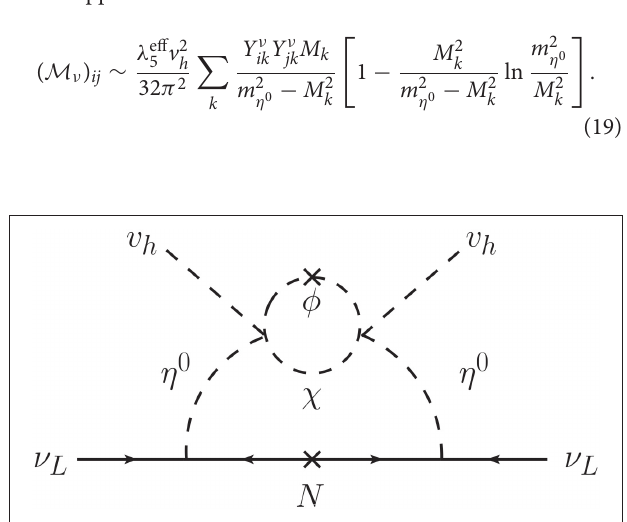
FIGURE 2 | Two-loop radiative neutrino mass of the model